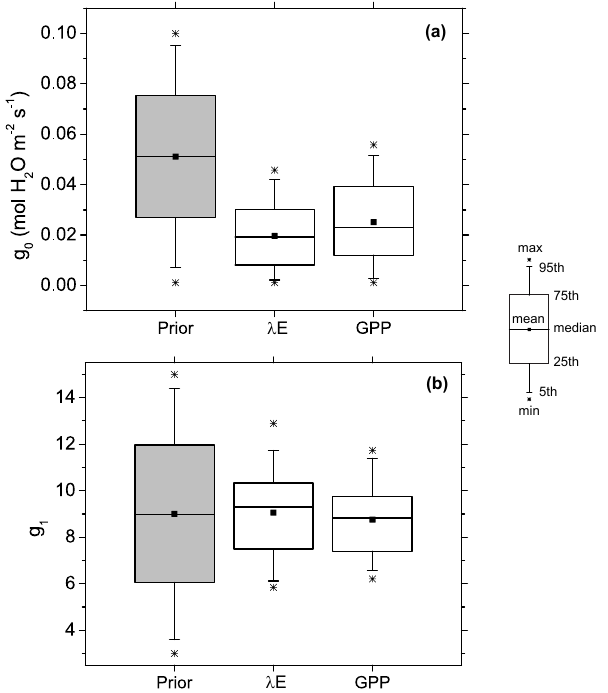
Figure 15. Parameter optimization of (a) g 0 and (b) g 1 for the CLM Ball–Berry model using flux data for US-Ha1 (July 2001). Shown are the distributions of prior parameter values from latin hy- percube sampling ( m = 500 points with n = 2 variables) and the parameter values of the 50 simulations with the lowest root mean square error for latent heat flux ( λE ) and gross primary production (GPP). For the 50 simulations, RMSE = 37–41Wm − 2 and 4.09– 4.15µmolCO 2 m − 2 s − 1 .